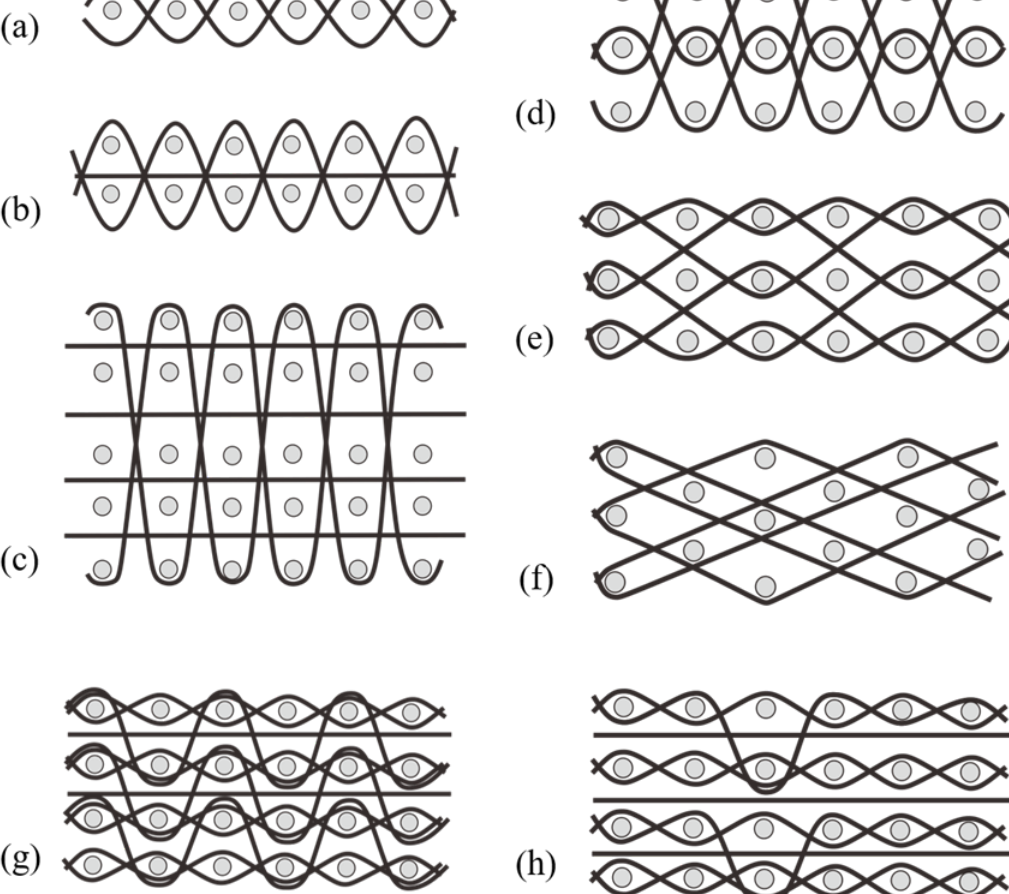
Figure 7. Sectional view of monolayer and multilayer wove structures: ( a ) monolayer woven structure; ( b ) two-layer woven structure; ( c ) five-layer whole orthogonal structure; ( d ) three-layer interlayer orthogonal structure; ( e ) three-layer integral angle interlock structure; ( f ) three-layer interlayer angle interlock structure; ( g ) four-layer binding structure; ( h ) four-layer self-interlacing structure.